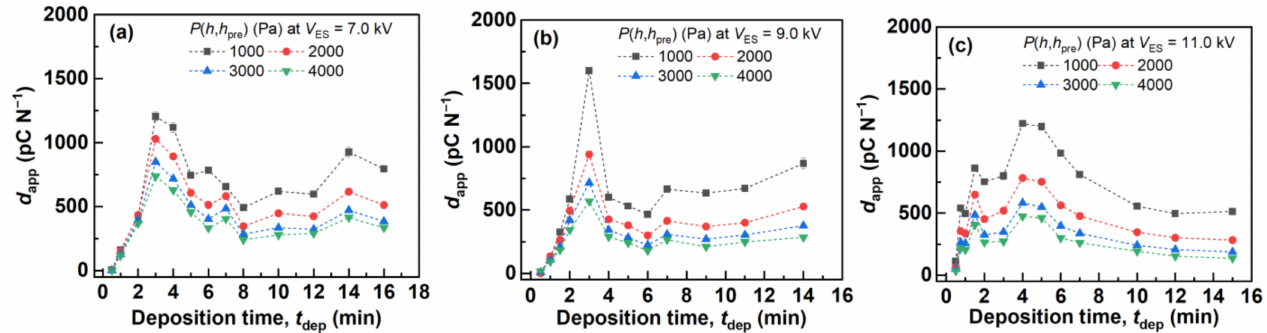
Figure 4. d a pp measured from the aPS fiber mats produced with different t dep and V ES . ( a ) 7.0, ( b ) 9.0, and ( c ) 11.0